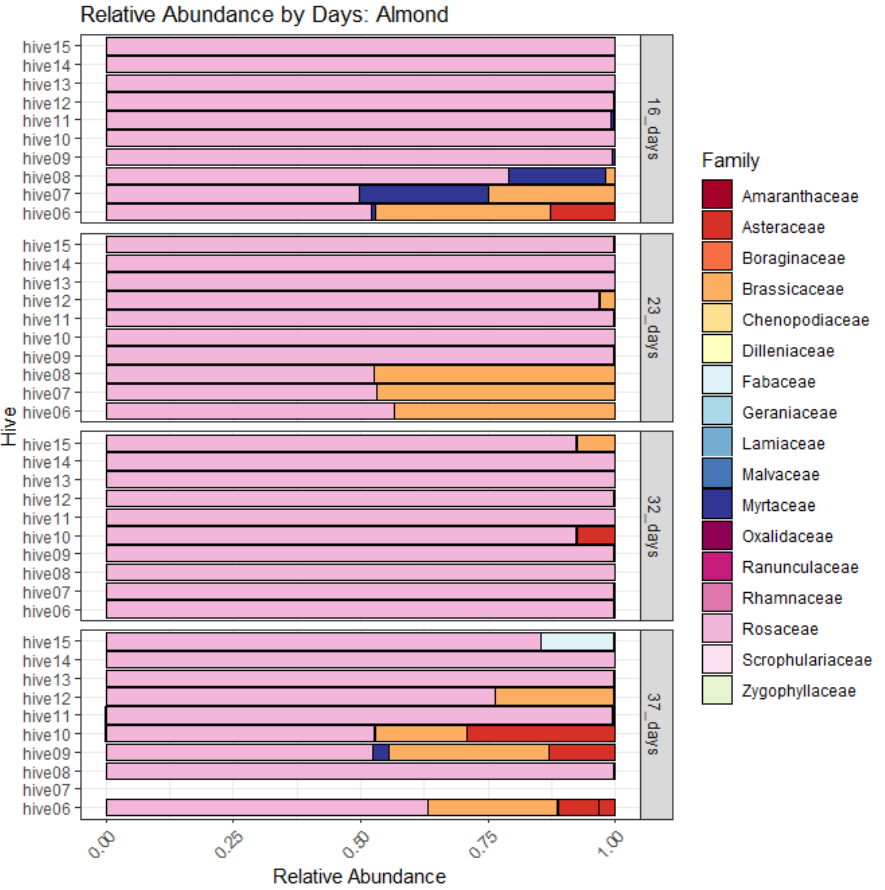
Figure 10. Composition of amplicon sequence variants (ASVs) concatenated by plant families from